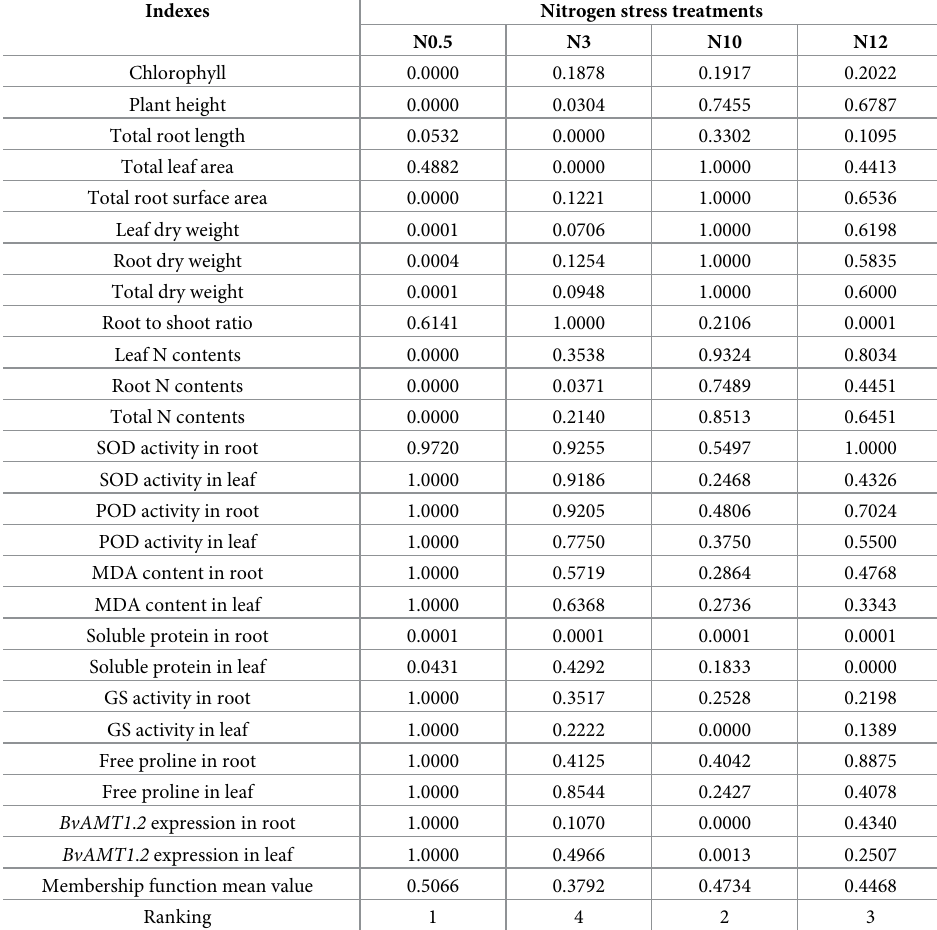
Table 6. Comprehensive evaluation of different nitrogen stress ability in sugar beet seedling